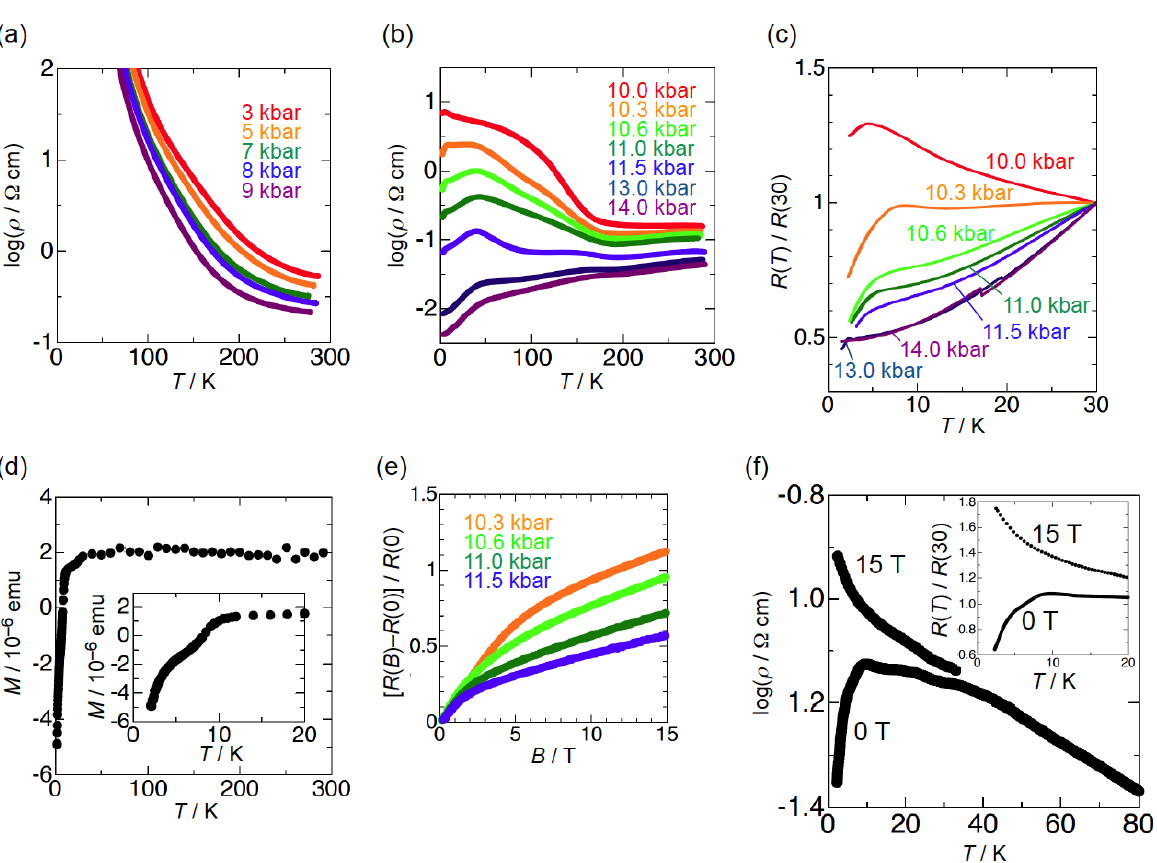
I ( a ) under 2 3 I below 2 3 I under a magnetic field of 0.1 T at 10 kbar. The inset 2 3 I 2 3 I at 9.7 kbar. The inset shows the 2 3